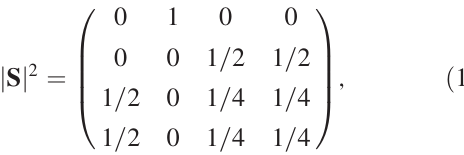
ffiffiffiffiffiffiffiffiffiffiffiffiffiffi 2 C − 1